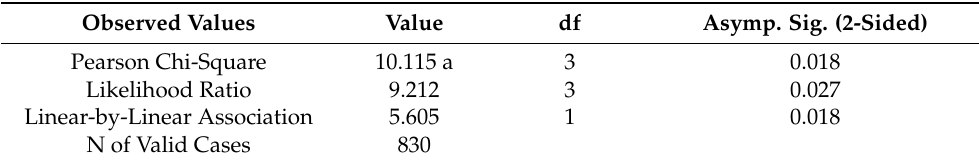
Table 5. Chi-Square results for the associations between participation in courses or trainings related to the use of online platforms and the students’ level of digital